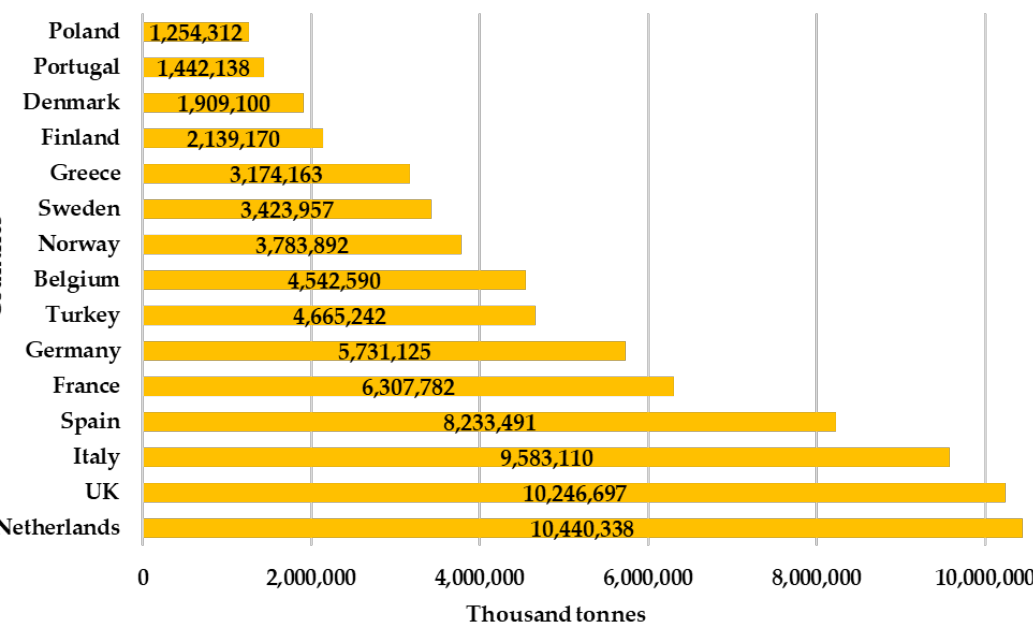
Figure 6. Top 15 European countries regarding the number of goods registered in the period 2001–2020.